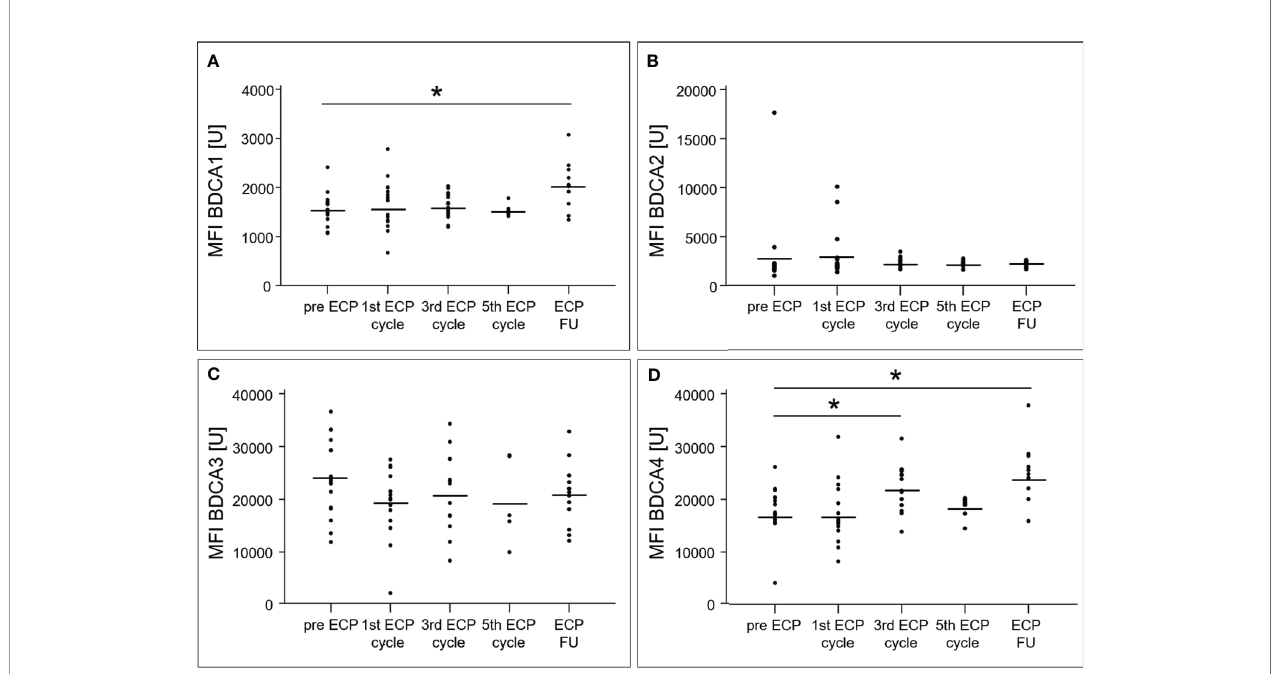
FIGURE 3 | Mean fl uorescence intensities of blood dendritic cell antigens 1 (A) , 2 (B) , 3 (C) and 4 (D) of dendritic cells in heart-transplanted patients receiving extracorporeal photopheresis. * marks signi fi cant differences (p ≤ 0.05); BDCA1/2/3/4, blood dendritic cell antigen 1/2/3/4; ECP, extracorporeal photopheresis; FU, follow-up; MFI, mean fl uorescence intensity; U,